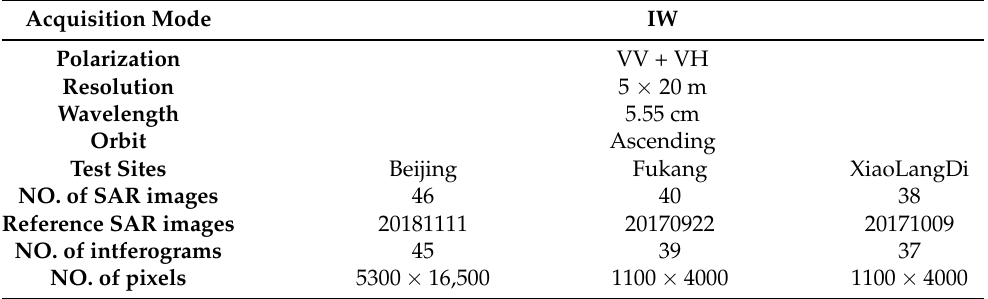
Figure 3. The temporal and perpendicular baseline of the generated interferogram stack over the ( a ) Beijing, ( b ) Fukang, and ( c ) XiaoLangDi test site, respectively. The filled diamonds and the crosses represent reference (primary) and secondary SAR images forming the interferograms, respectively. Table 1. Key parameters of the employed Sentinel-1 data